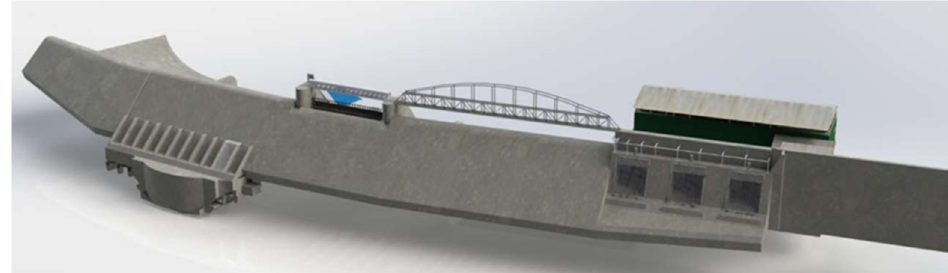
Figure 3. Upstream view of the overall Chenderoh Dam.